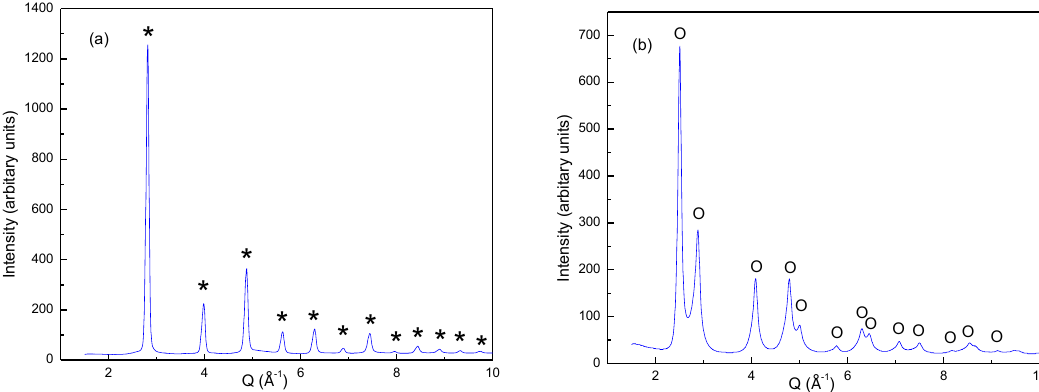
Figure 2. Synchrotron radiation powder X-ray diffraction (SR-PXD) data of ( a ) the deuterium-free BCC alloy Ti 0.63 V 0.27 Fe 0.10 and ( b ) the FCC deuteride Ti 0.63 V 0.27 Fe 0.10 D 1.73 . Bragg peaks corresponding to BCC and FCC are marked with asterisks (*) and circles ( ○ ), respectively.